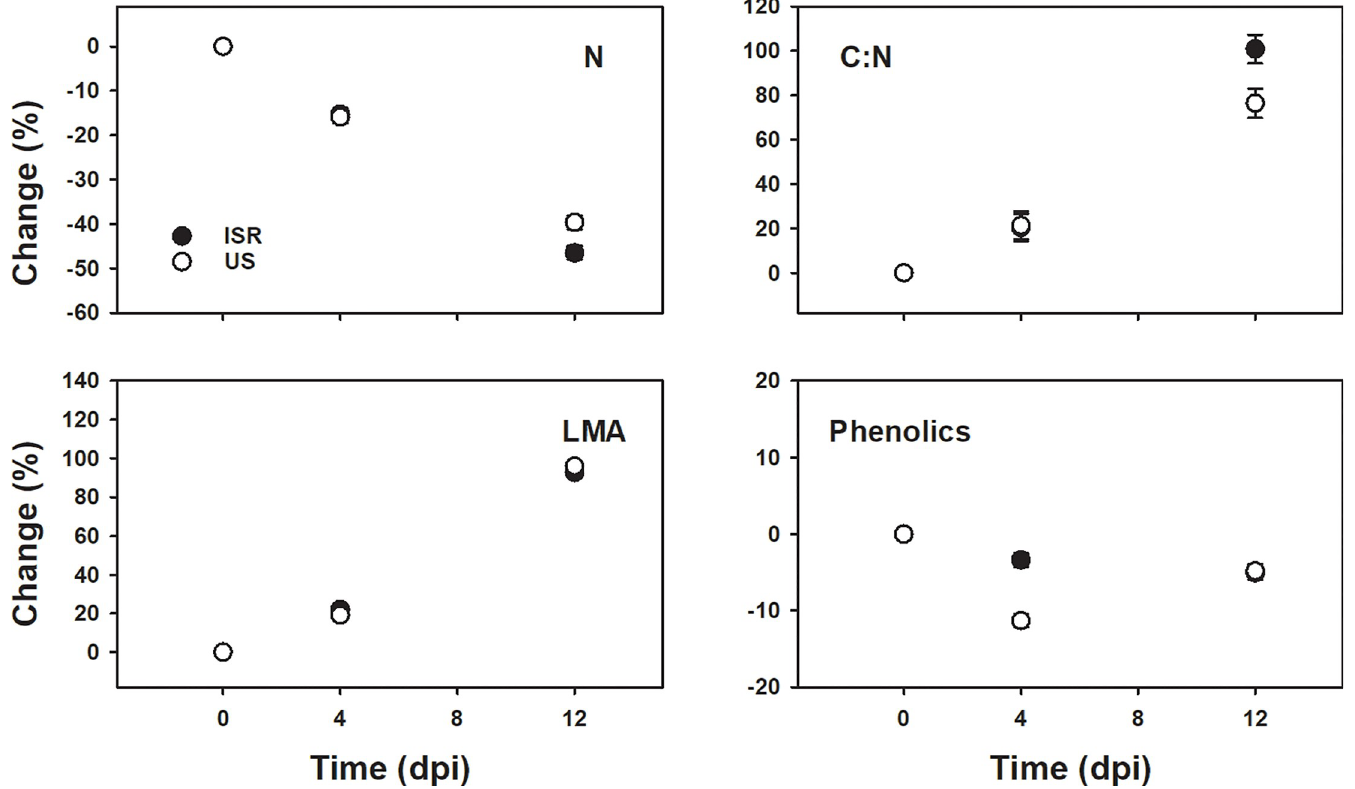
Fig 5. Mean ± SD of relative changes, compared with the pre-infestation averages, of nitrogen (N), ratio of carbon to nitrogen (C:N), leaf mass per area (LMA) and phenolics of compatible genotypes (H13-US, US; H13-Israel, ISR) at zero, four and twelve days post infestation (dpi).